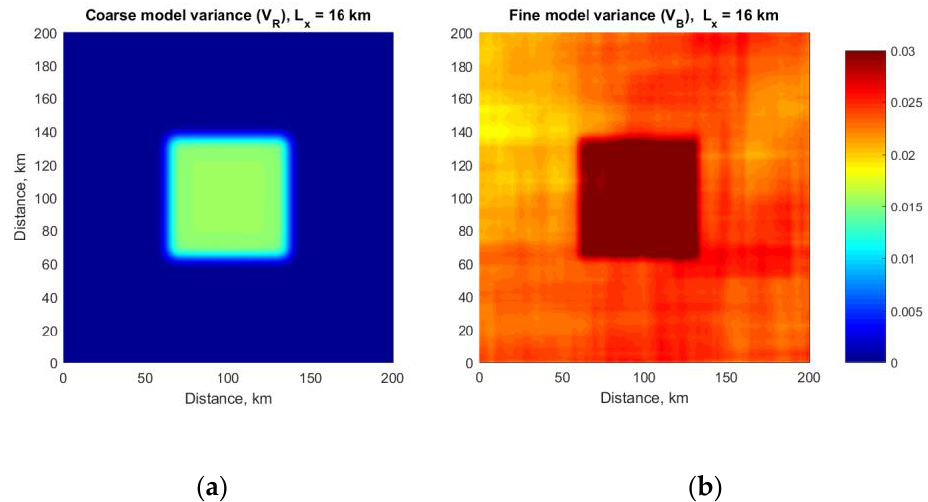
Figure 7. Dependence of RMSE for different eddy sizes: before data assimilation (black), after NDA assimilation (blue), the ratio of RMSE after and before data assimilation (red).